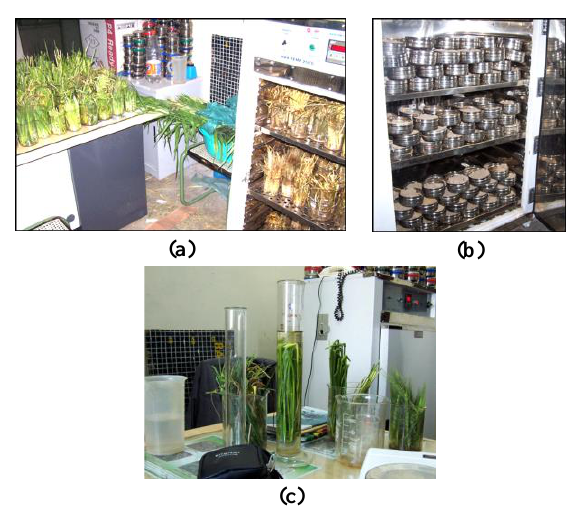
Figure 2. Measurement of (a) dry biomass, (b) soil moisture, and (c) crop